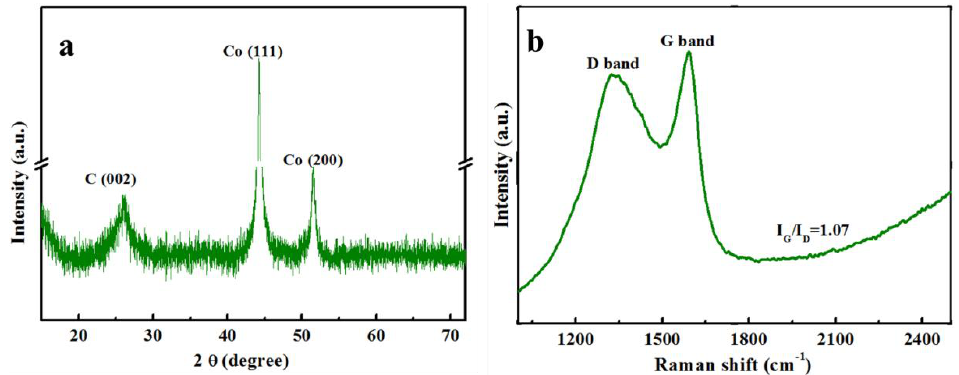
Figure 2. ( a ) X-Ray diffraction (XRD) pattern and ( b ) Raman spectrum of the MNPC. Figure 2. ( a ) X-ray diffraction (XRD) pattern and ( b ) Raman spectrum of the